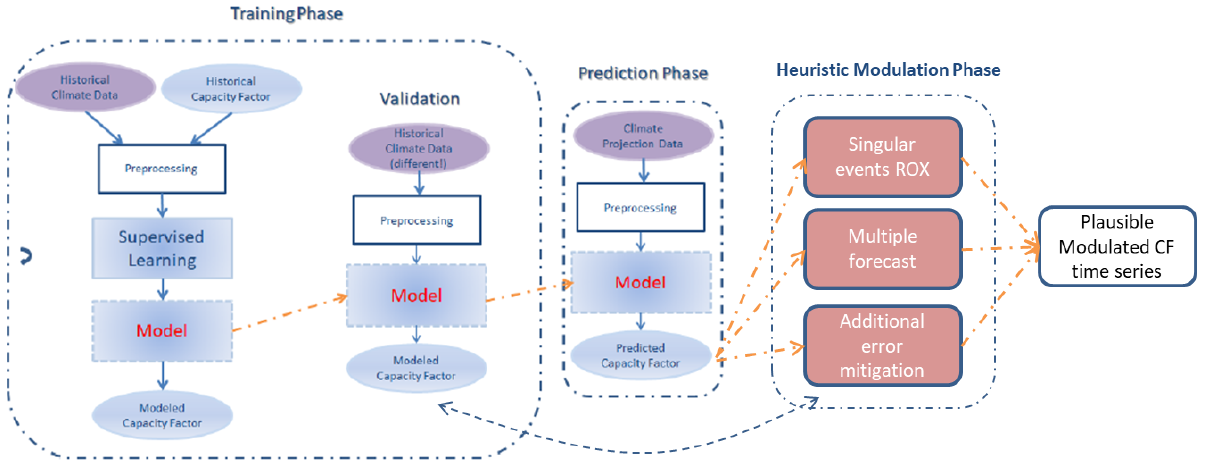
Figure 12. Post-processing applied to the ML model